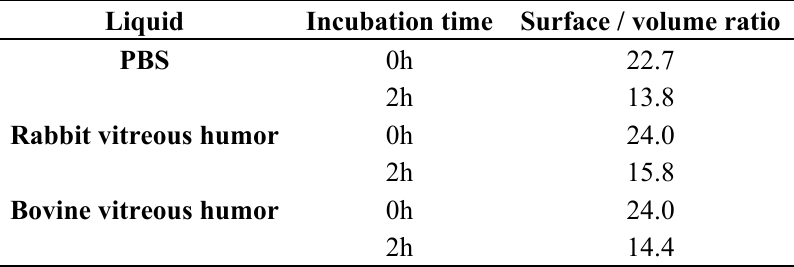
Table 2. The surface/volume ratio of the PEA fibrils decreased from 22–24 before incubation to 13–16 after 2 h of incubation in PBS or vitreous